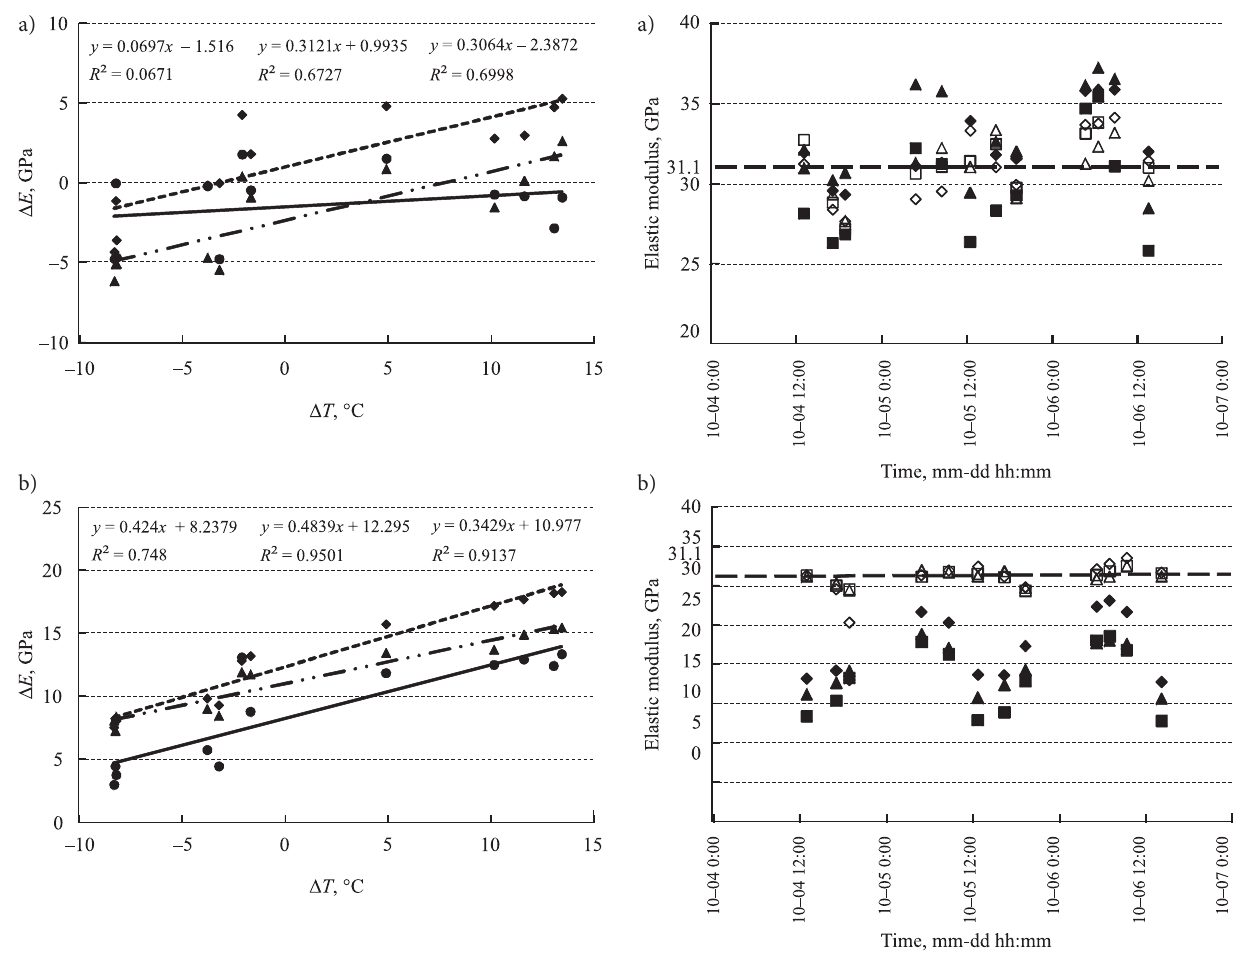
Fig. 8. Linear relationship of difference between measured and backcalculated elastic modulus with temperature difference: